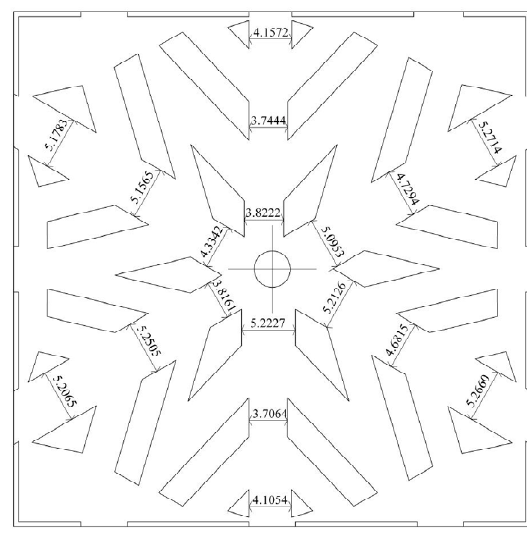
Figure 10. Flow diagram of MOGA optimization for the snowflake flow channel fuel cells.